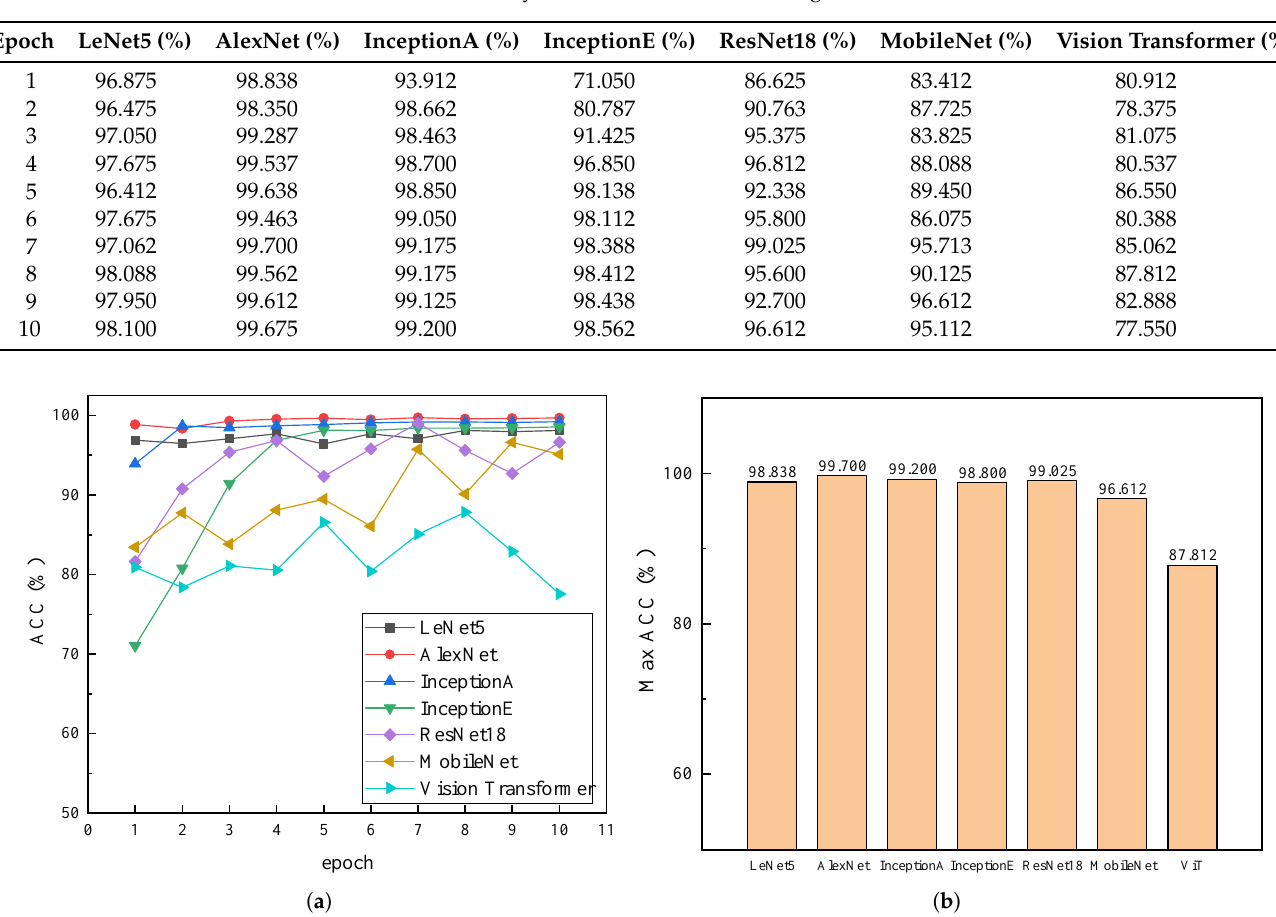
Table 5. Accuracy of each model after data augmentation.